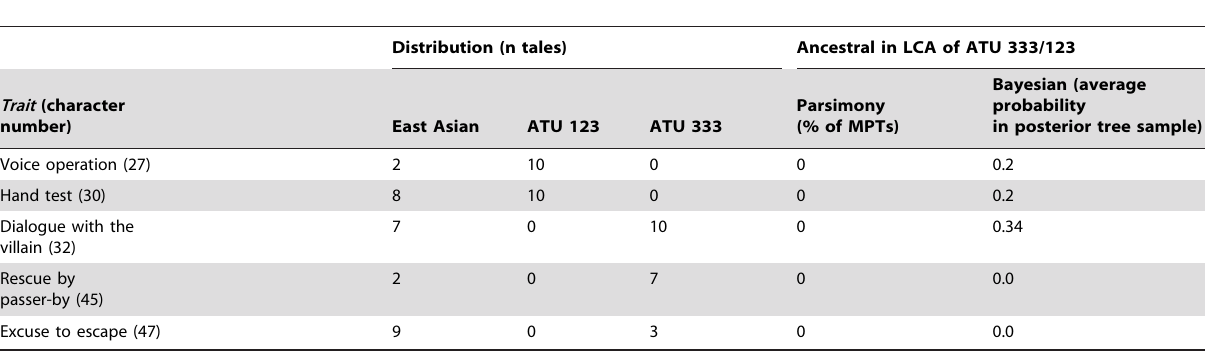
Table 1. Reconstructed ancestral states for traits shared between East Asian tales and ATU 123 and ATU 333.